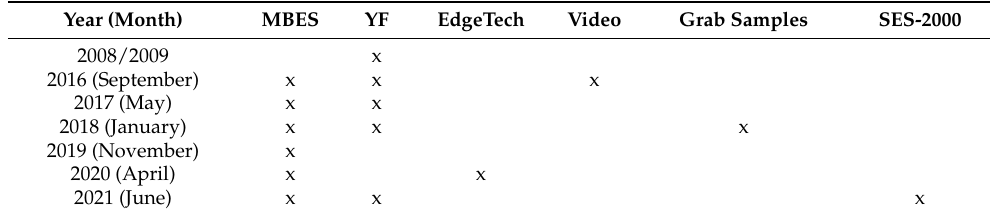
Table 1. Overview of the different datasets acquired over the last 13 years. MBES—Multibeam Echo Sounder,